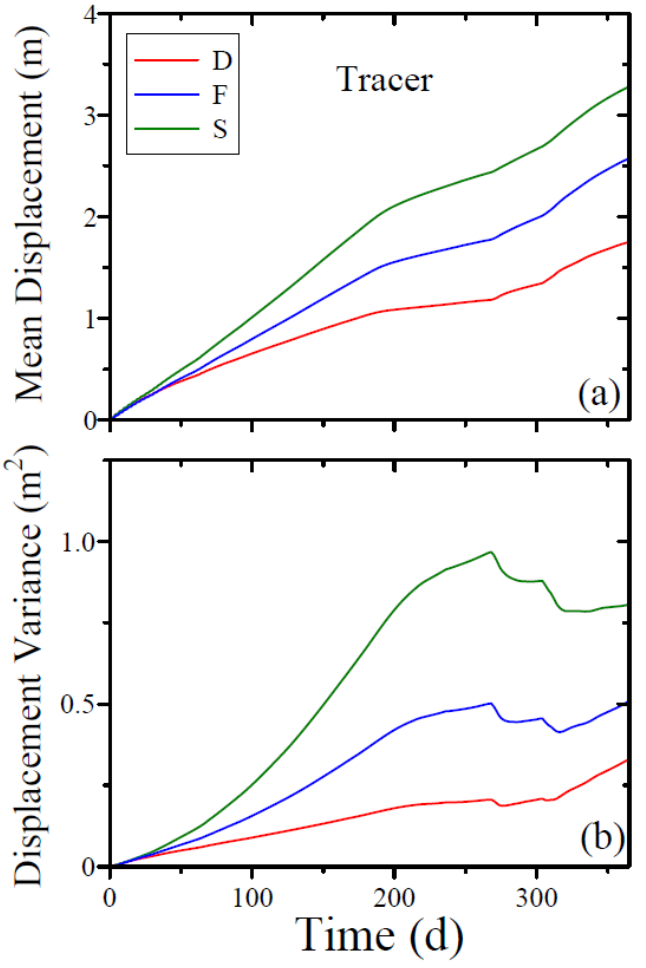
Figure 5. ( a ) Vertical position of the centroid of the tracer mass, Zc, and ( b ) the spread about it in the vertical direction, S 11 , as functions of time, for the different scenarios examined.